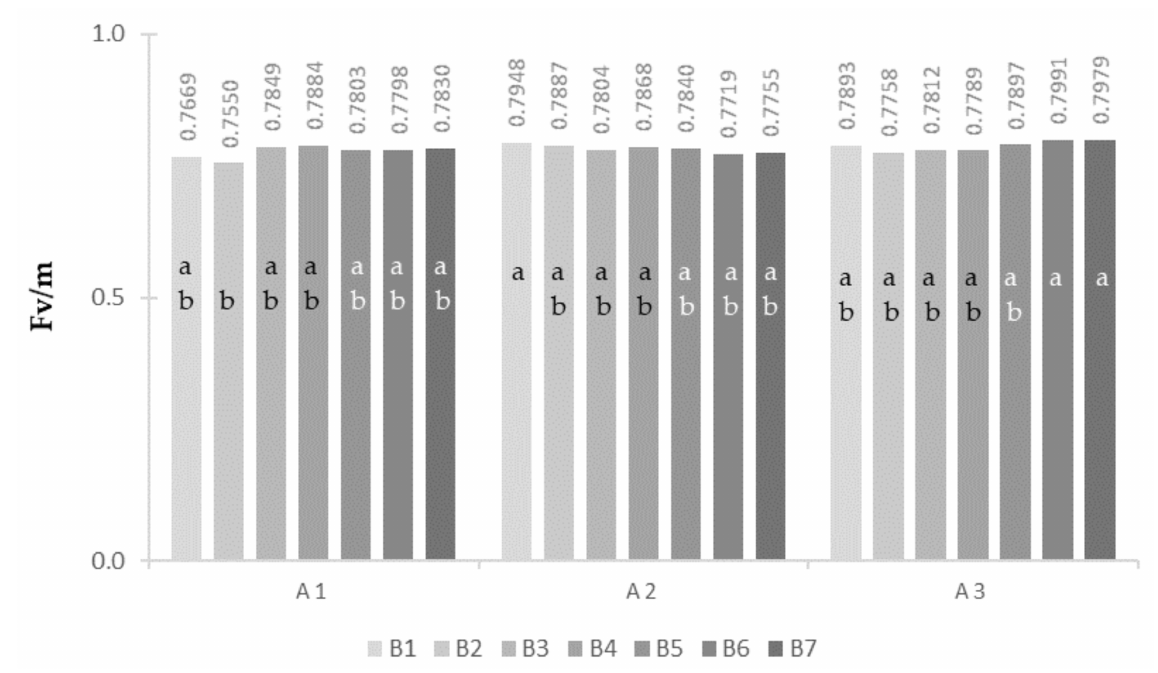
Figure 2. Average Fv/m values for the combination of the cultivar (A) and type of fertilizer (B). Values marked with at least one same letter are not significantly